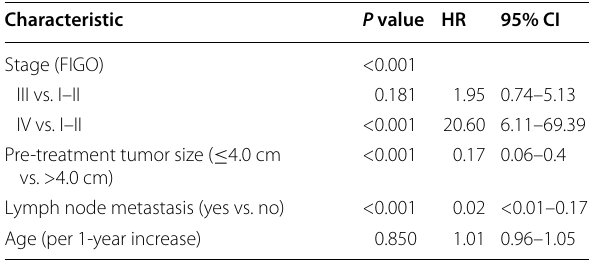
Table 2 Univariate analysis of factors related to 3-year overall survival rate of cervical cancer patients